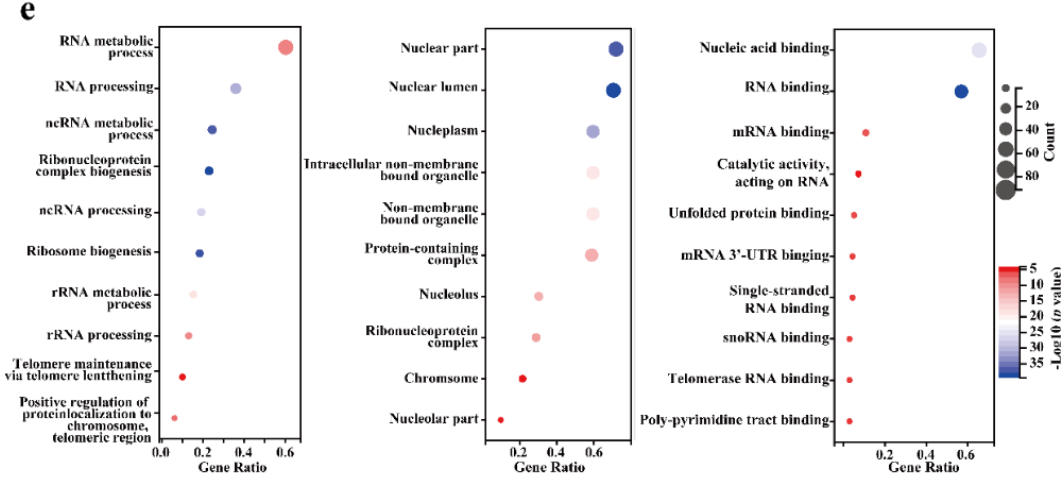
Figure 6. Enrichment analysis of NOL7 -related genes. ( a ) The top 100 genes related to NOL7 expression were obtained from the TCGA project, and the correlations between NOL7 expression and selected target genes, including MCUR1 , EEF1E1 , SSB , DHX9 , WRNIP1 , and ABT1 , were analyzed using GEPIA2. ( b ) A PPI network of 50 experimentally verified NOL7 -interacting proteins. The corresponding heatmap data for the detailed cancer types are shown below. ( c ) An intersection analysis of the NOL7-interacting and NOL7-correlated genes was conducted, and four genes were obtained, including NIFK , MPHOSPH10, NOL10 , and WDR12 . ( d ) KEGG pathway analysis of NOL7 -interacting genes and NOL7 -correlated genes. ( e ) GO analysis of NOL7 -interacting genes and NOL7 -correlated genes. Enrichment results for biological processes ( left ), cellular component ( middle ), and molecular functions ( right ) are